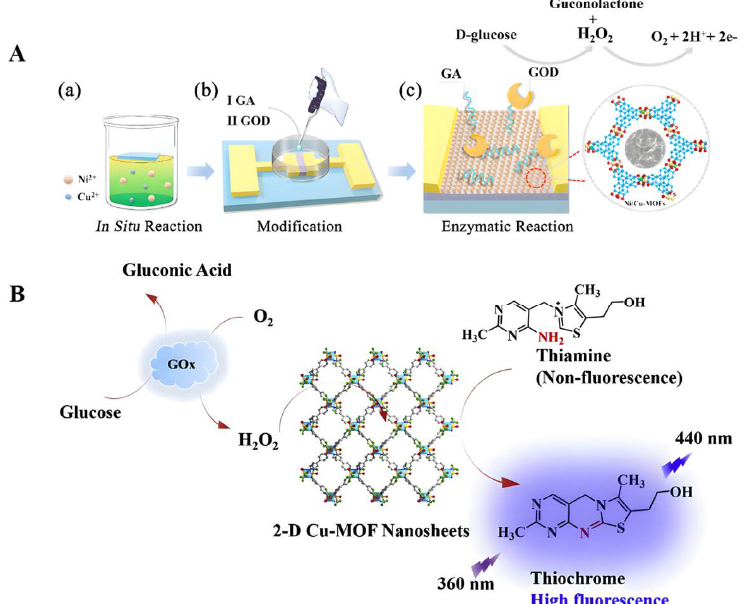
Figure 2. ( A ) Schematic diagram of the fabrication, modification, and principle of the glucose detection of GOD-GA-Ni/Cu-MOFs-FET. ( a ) FET was suspended on the surface of a reaction solution with mixed metal ions. Insert shows the response time of the sensor to glucose. ( b ) The Ni/Cu-MOFs were modified by dropping GA and GOD sequentially for cultivation. ( c ) Ions generated from the enzymatic reaction of glucose accumulated on the surface of bimetallic MOF films, inducing a change in charge concentration. Reproduced with permission [67]. Copyright 2021, Journals & Books. ( B ) The working mechanism of 2D Cu-MOF nanosheets. Reproduced with permission [75]. Copyright 2019, Analytica Chimica Acta .